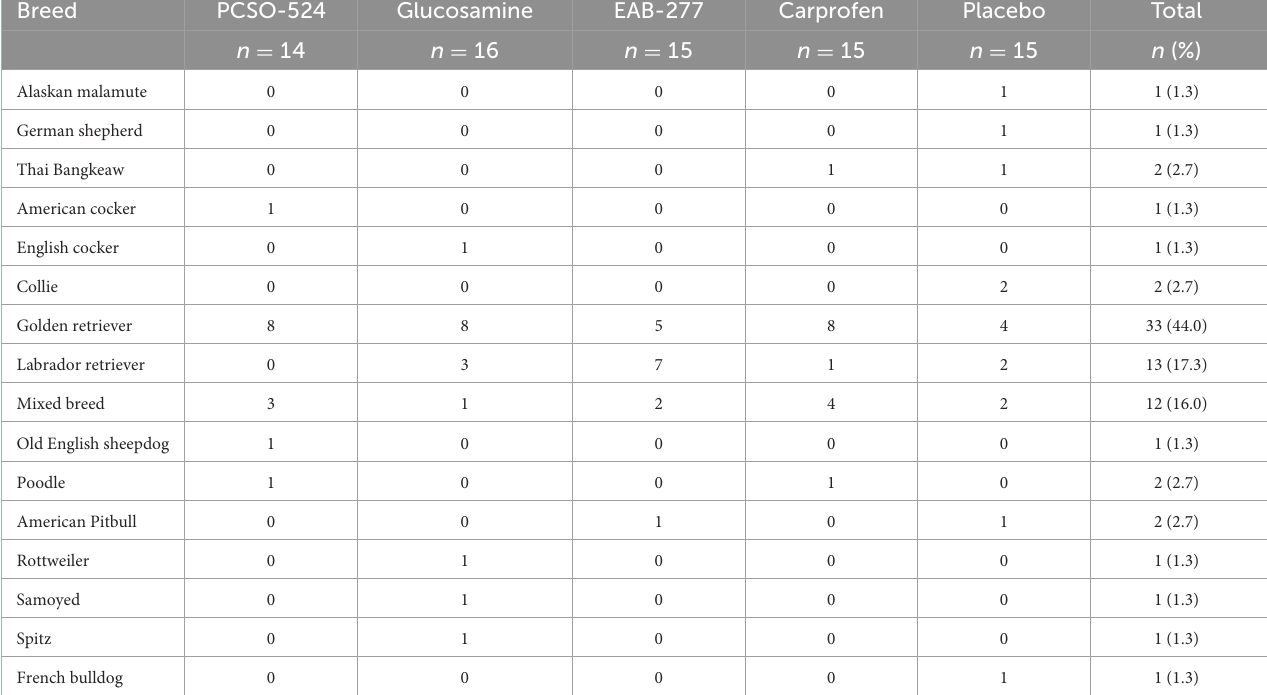
TABLE 3 Breed of dogs and distribution ( n ) within the treatment group in the study. Breed